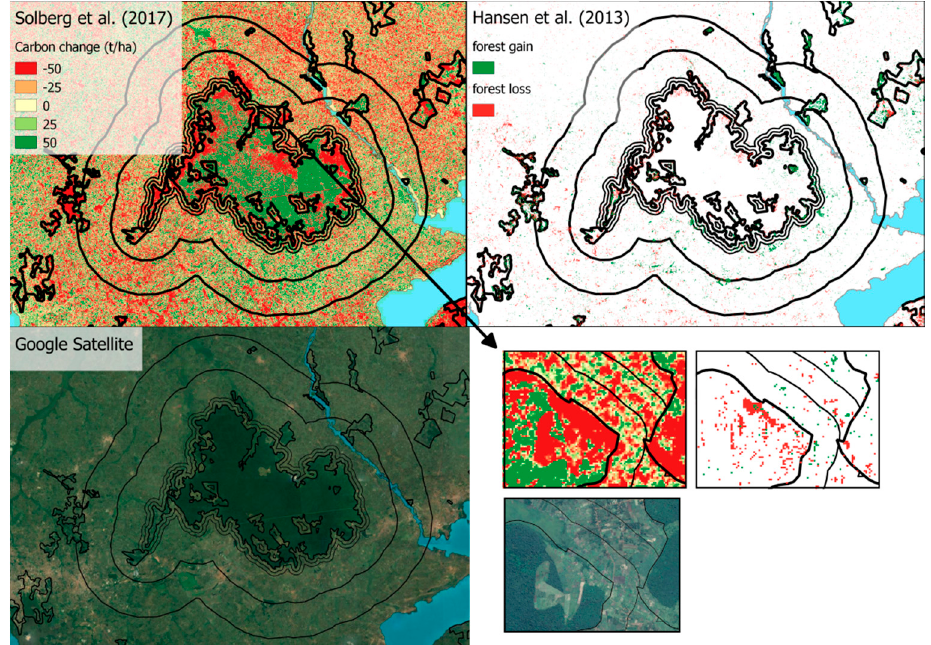
Figure 6. Leakage in “Effective” PA (Karuma WLR, area = 57,000 ha), upper left panel, demonstrating a sharp contrast in carbon change between inside PA (carbon gain) and external buffer zones (carbon loss). Additional figures are for visual comparison, extracts of Google Earth images and Global Forest watch, and forest cover change for the same period (2000–2012) [34].